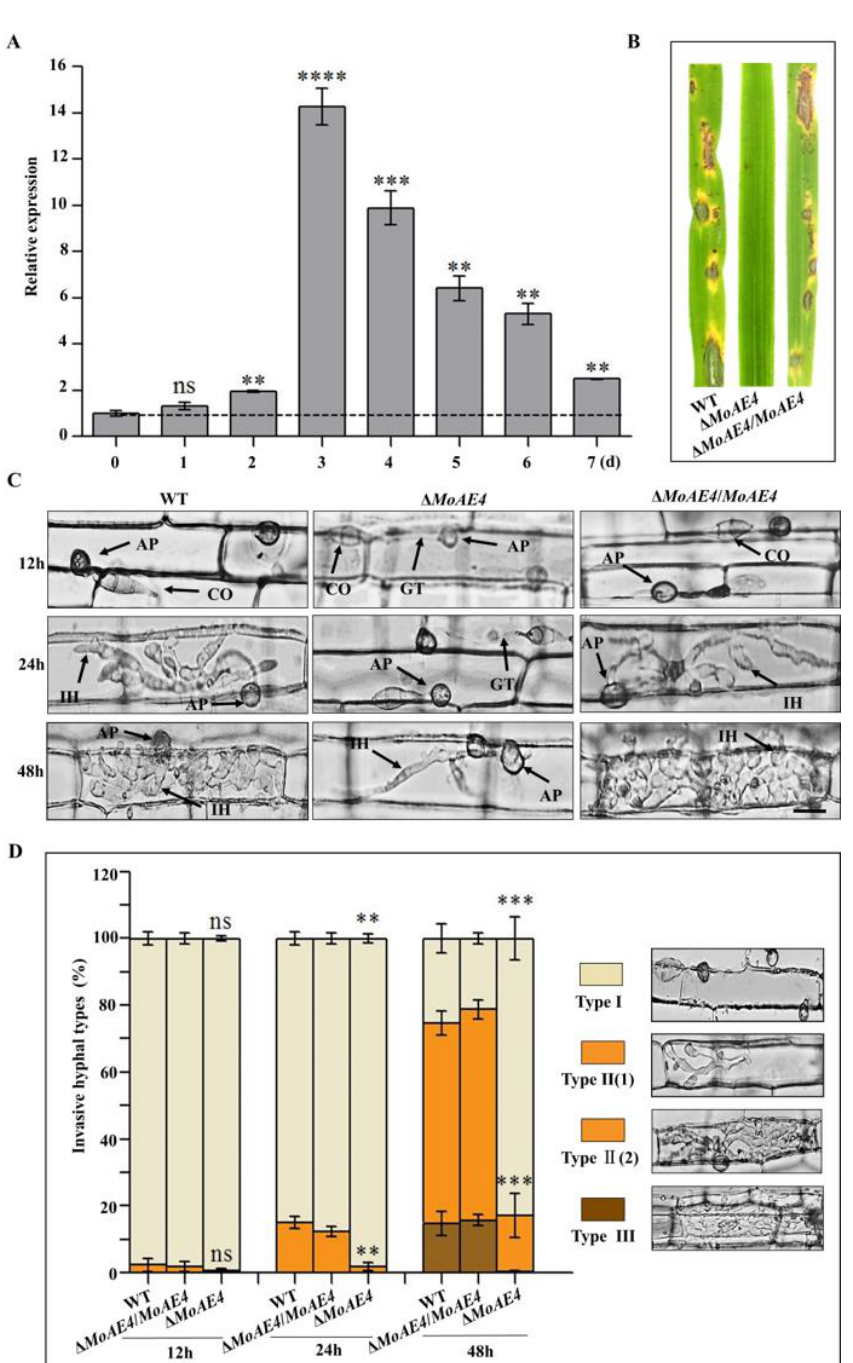
Figure 6. Pathogenesis analysis of the wild type and created strains. ( A ) Transcription abundance of MoAE4 during disease development. ( B ) Spray-inoculation assay. ( C ) Rice leaf sheath infection assay. Scale bar = 10 μm. IH, infectious hyphae;